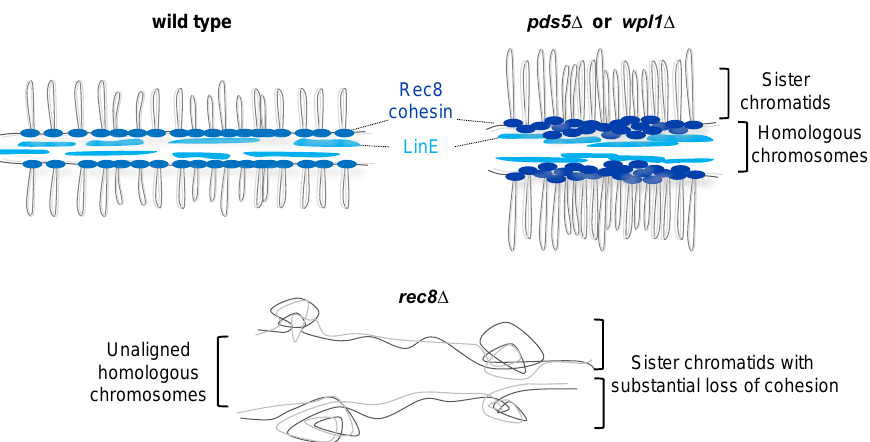
Figure 7. Chromosome architectures regulated by Pds5, Wpl1 and Rec8 in S. pombe. The Rec8-dependent loop-axis structure and linear element (LinE) are shown. It is unclear whether the same Rec8 cohesin complex is responsible for both cohesion and loop formation or whether different subsets of Rec8 cohesin are used at each step